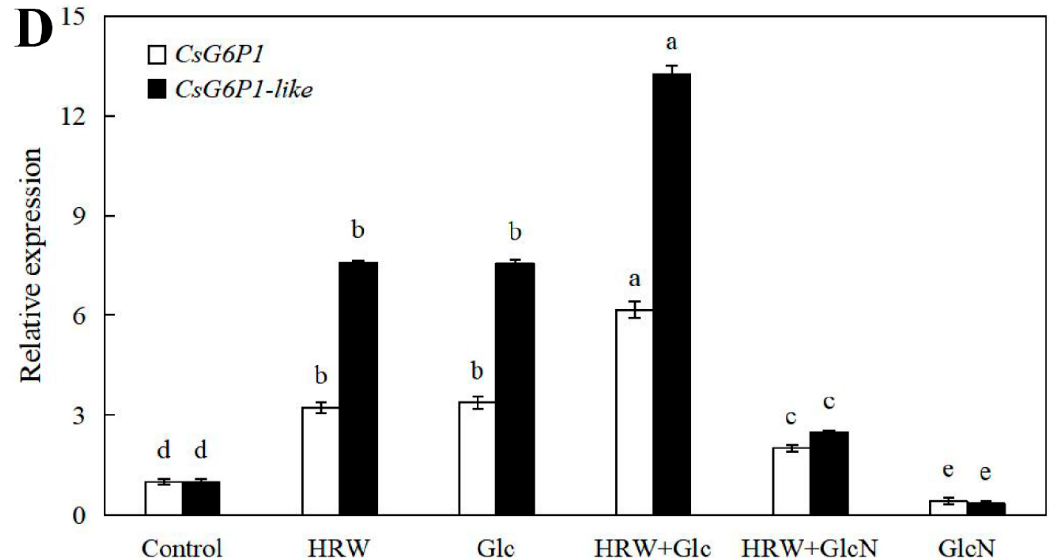
Figure 5. Effects of HRW, Glc and GlcN on the expression levels of CsSuSy1 and CsSuSy6 ( A ), CsHK1 and CsHK3 ( B ), CsUDP1 and CsUDP1-like ( C ), CsG6P1 and CsG6P1-like ( D ) genes in cucumber explants. n = 30 explants per replicate. Bars with different lower case letters were significantly different ( p < 0.5). HRW: hydrogen rich water; Glc: glucose; GlcN: glucosamine.